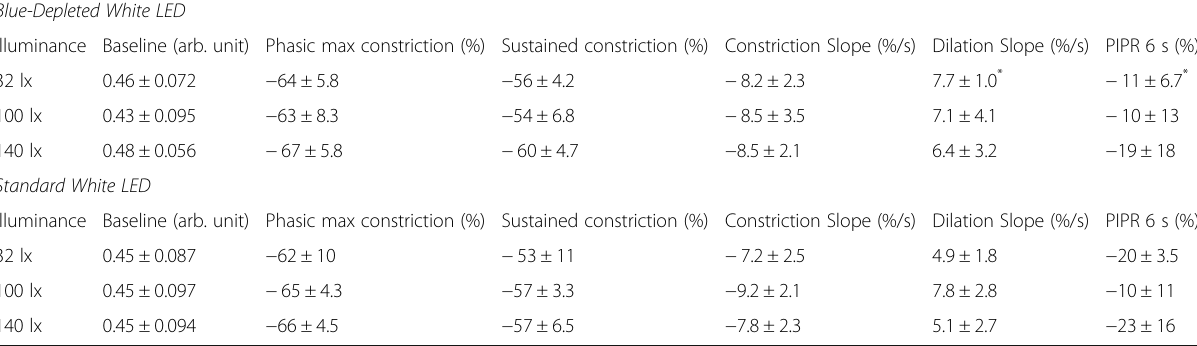
Table 1 Pupil responses to light Blue-Depleted White